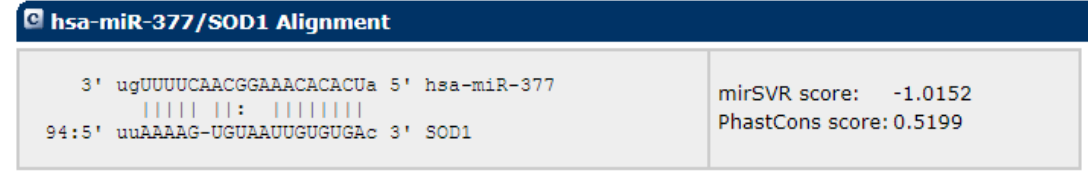
Table 1. Reaction between miR-377-3p and the SOD gene in the microrna